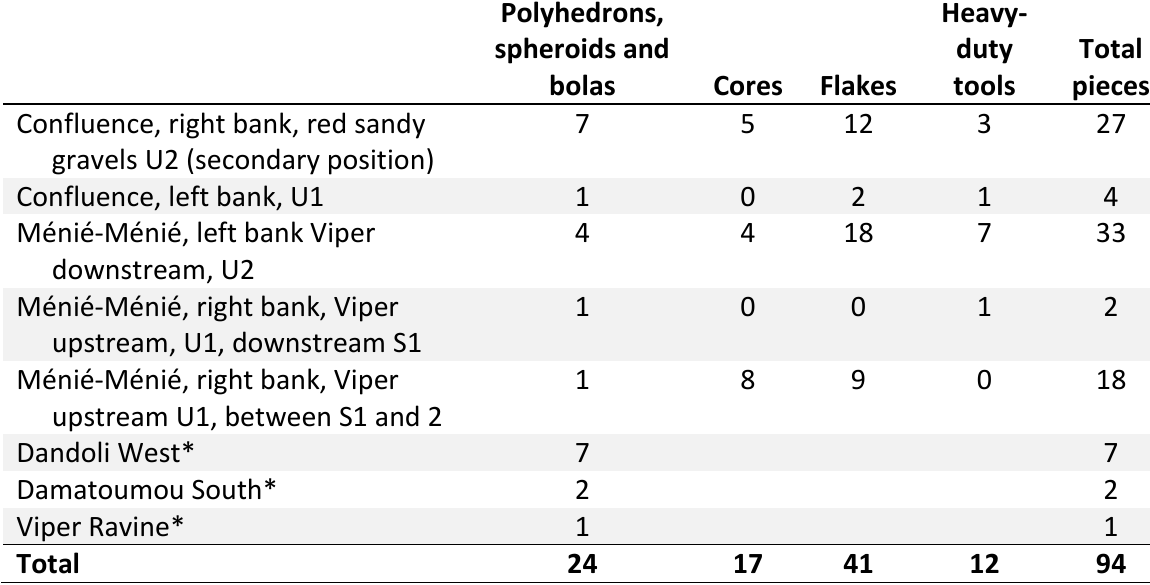
Table 1. Lithic assemblage collected in U1 and U2 at Ounjougou complex. Abbreviations: * - In these sites, only polyhedrons and spheroids were